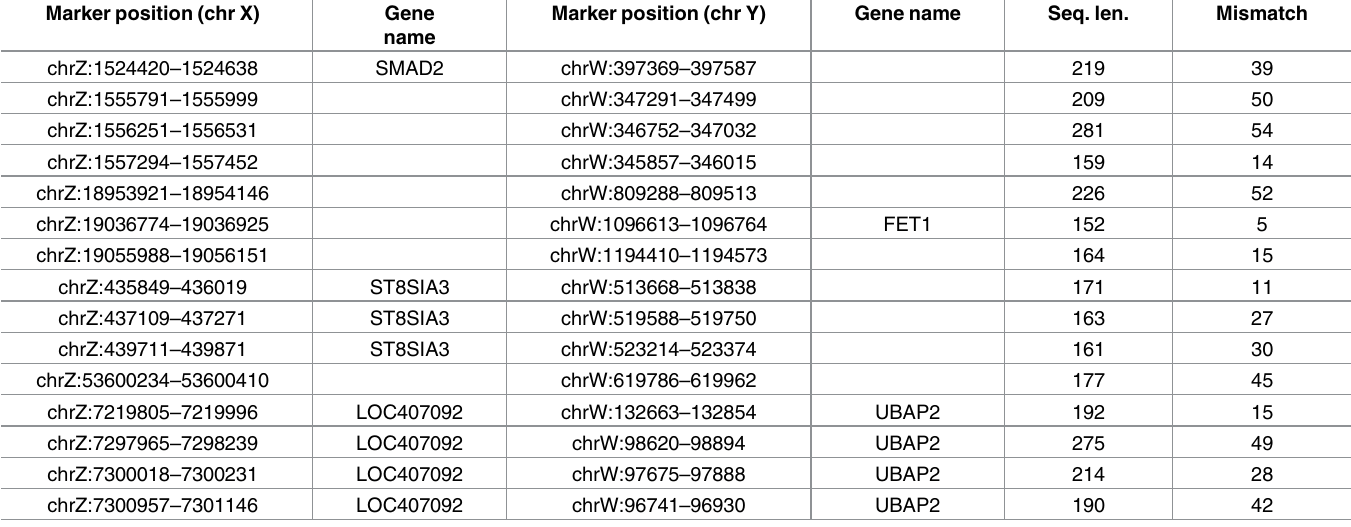
Table 3. Sex-specific markersequences for chickens.